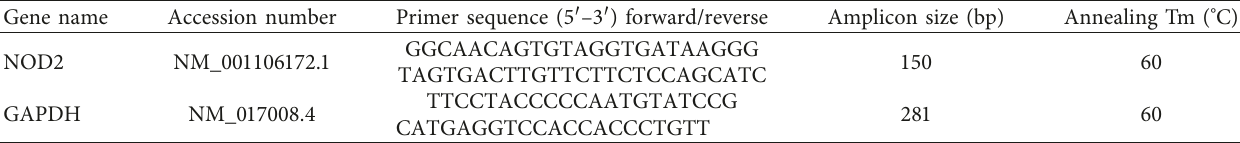
Table 1: Description of reference genes, primer sequences, and amplicon